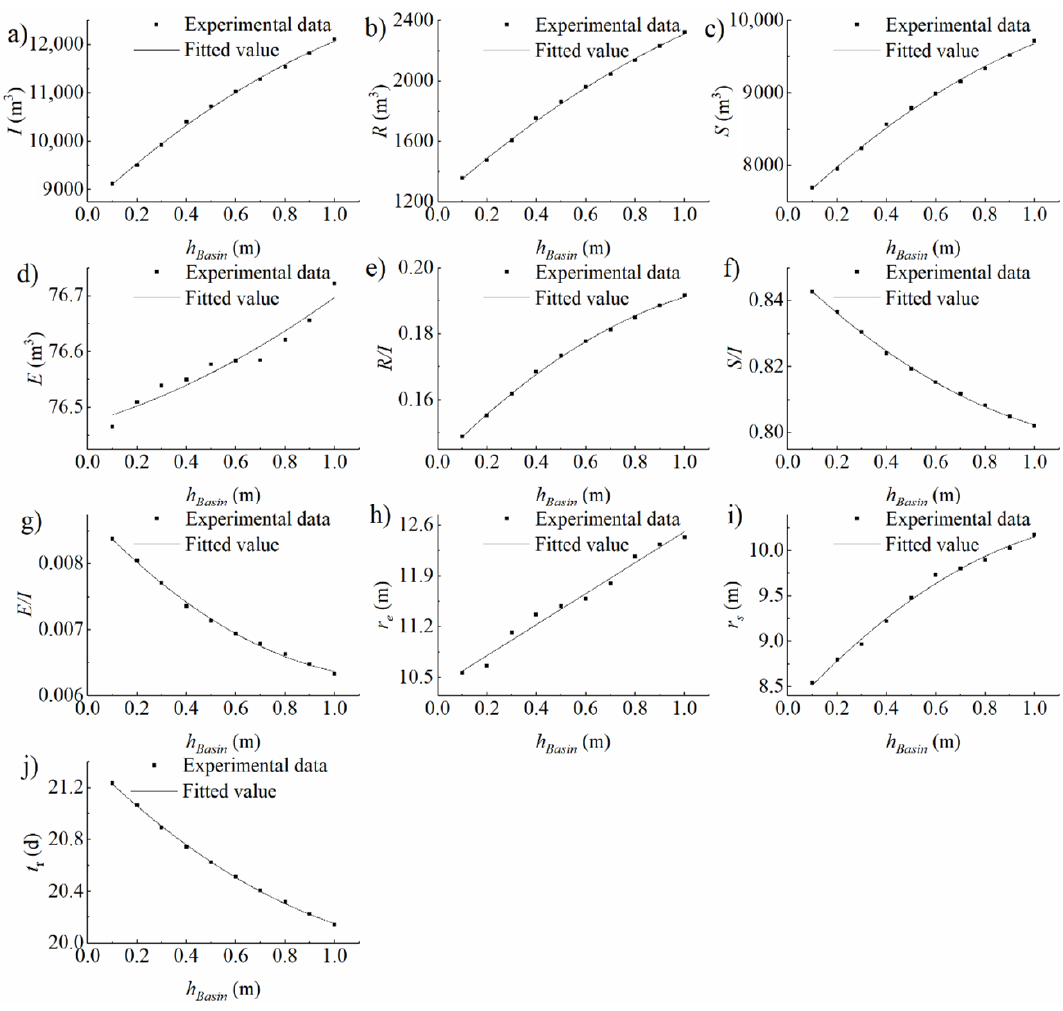
Figure 2. The variations with an increment in h Basin . (( a ) variation of I; ( b ) variation of R; ( c ) variation of S; ( d ) variation of E; ( e ) variation of R/I; ( f ) variation of S/I; ( g ) variation of E/I; ( h ) variation of r e ; ( i ) variation of r s ; ( j ) variation of t r .).